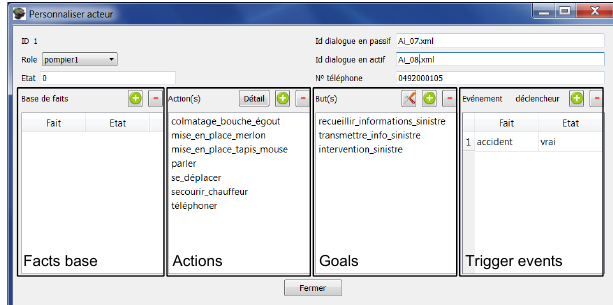
Figure 5. The Game Agent